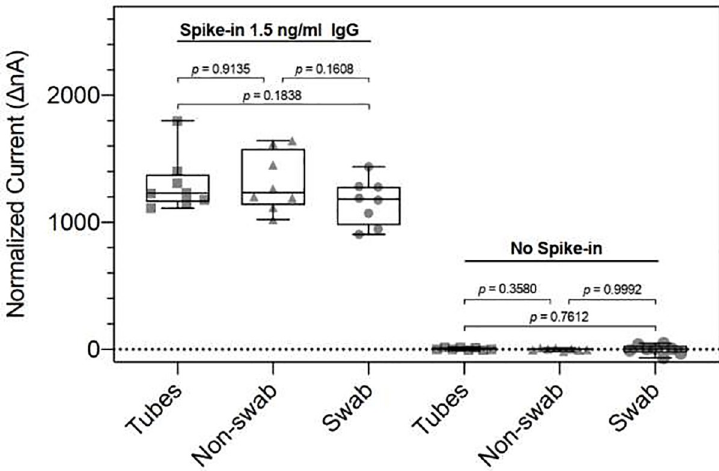
Fig 4. Box plot of saliva matrix experiments with saliva from healthy subjects. Green dashed line represents 5 standard deviations above the mean.